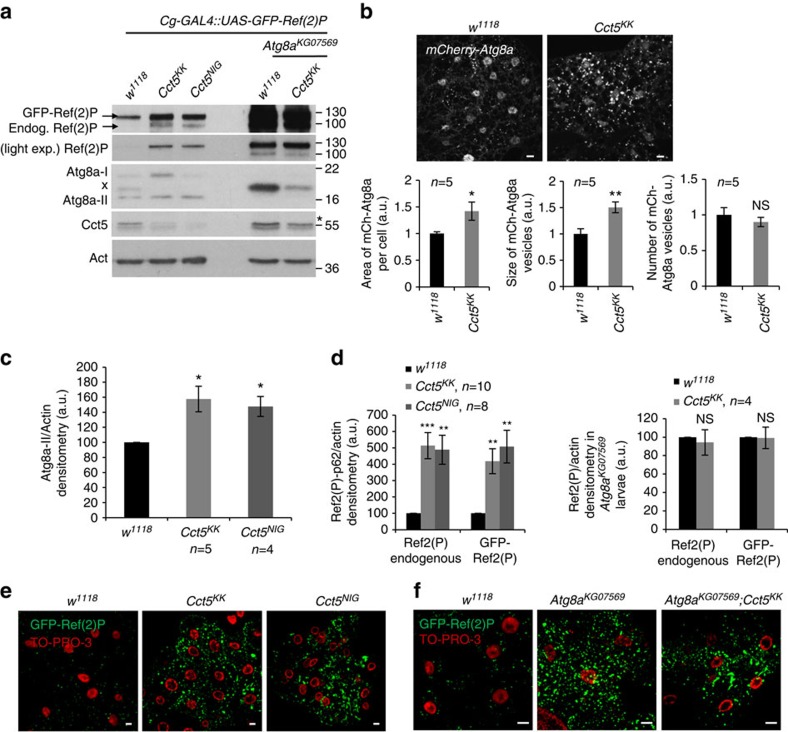
The increase of p62 levels and aggregation after Cct5 depletion in Drosophila is autophagy dependent.(a) Biochemical assessment of autophagy upon Cct5 knockdown in fat body of third instar larvae expressing GFP-Ref(2)P (Cg-GAL4 UAS-GFP-Ref(2)P) and either the RNAi for Cct5 alone (using either Cct5KK or Cct5NIG) or Cct5KK in Atg8aKG07569 mutant background. VDRC w1118 (stock number 60100) was used as background control. Three larvae were lysed, and equal amounts of proteins for each control and test genotype were used for western blot analysis. Both Atg8-II and Ref(2)P (both GFP-tagged and endogenous) levels increased upon Cct5 knockdown, while Cct5 knockdown did not obviously influence Ref(2)P levels in Atg8a mutant fat bodies. x—non-specific band. Actin—loading control. See also Supplementary Fig. 12b. (b) Representative confocal images of fat body cells from third instar larval progeny of Cg-GAL4 UAS-mCherry-Atg8a crossed to either VDRC w1118 (stock number 60100, background control) or Cct5KK. Bars—mean±s.e.m., five larvae per each condition, >25 cells per larva. Size of mCherry-Atg8a-positive vesicles increased in Cct5-depleted cells, suggesting defective autophagosome degradation. (n=5; NS, not significant, *P<0.05; **P<0.01; two-tailed t-test). Scale bar, 10 μm. (c) Atg8a-II levels in third instar larval fat bodies upon knockdown of Cct5 using Cg-GAL4, as in c. Bars—means±s.e.m., control ratio set to 100 (*P<0.05; two-tailed one sample t-test). (d) Quantification of GFP-tagged and endogenous Ref(2)P levels in third instar larval fat bodies upon knockdown of Cct5 using Cg-GAL4 as in c, either alone (top graphs), or in an Atg8a mutant background (Atg8aKG07569;Cct5KK, bottom graphs ). Bars—means±s.e.m., control ratio set to 100 (NS, not significant, **P<0.01, ***P<0.001; two-tailed one sample t-test). (e) Representative confocal images showing GFP-Ref(2)P in fat body of Cct5 knockdown (using Cg-GAL4) third instar larvae. GFP-Ref2(P)-positive aggregates accumulate in Cct5-depleted cells. TO-PRO-3 stains the nuclei. Experiment was repeated with similar results (n>3). Scale bar, 10 μm. (f) Representative confocal images showing GFP-Ref(2)P in larval fat body cells co-depleted for both Atg8a and Cct5 (Atg8aKG07569;Cct5KK109505). Cct5 knockdown did not obviously enhance the GFP-Ref(2)P phenotype of Atg8a mutants. Experiment was repeated with similar results. TO-PRO-3 stains the nuclei. Scale bar, 10 μm.